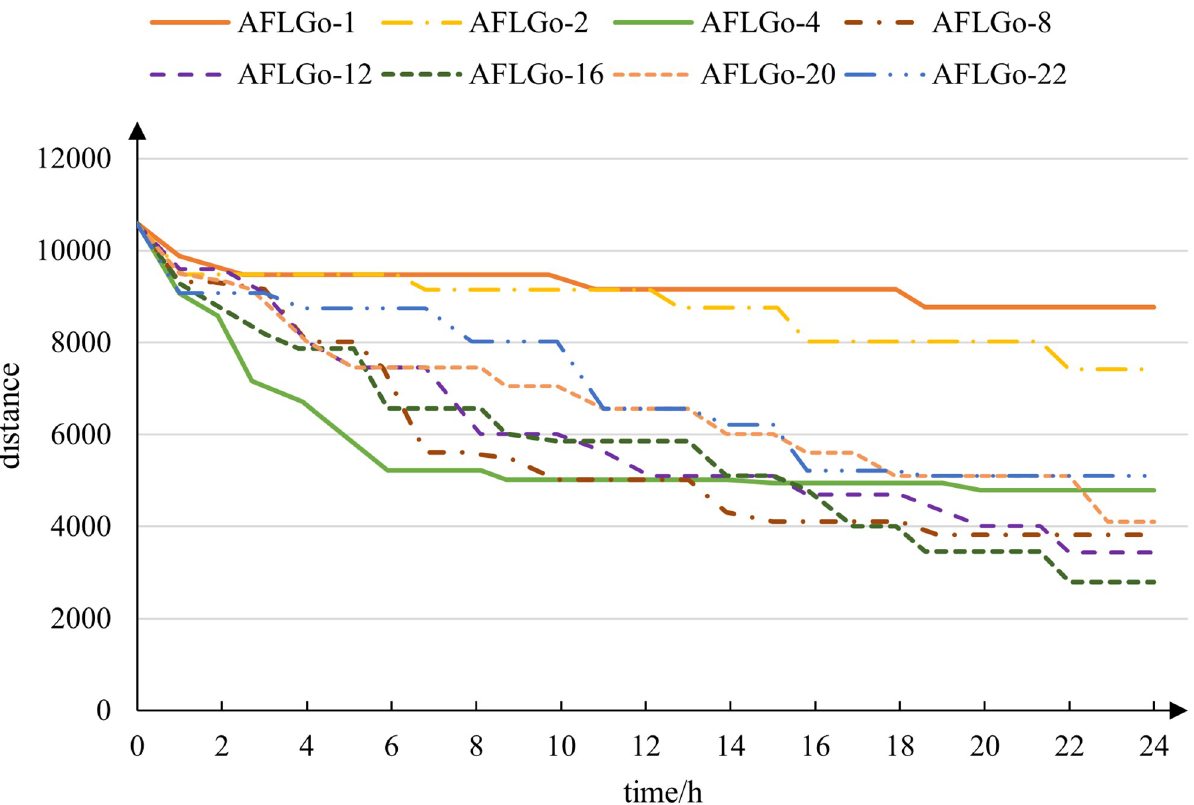
Fig 1. Minimum distance found by AFLGo against different exploration